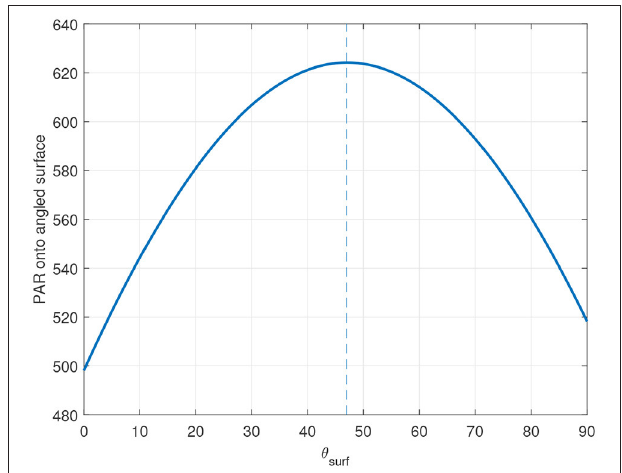
given sun height. Given the angle θ i , the script returned a direct and a diffuse PAR of λ dir = 540 µ mol m − 2 s − 1 and λ dif = 313 µ mol m − 2 s − 1 , respectively. PAR onto a plane normal to the direct irradiance is then λ ⊥ = λ dir + λ dif . By multiplying the direct PAR by the cosine of the sun angle and adding the diffuse PAR, we obtain the total PAR value for a horizontal surface as: λ k = cos (90 ◦ − φ i ) λ dir + λ dif . When reducing the λ ⊥ by the reflectivity factor we get the PAR = (1 − R )( λ dir + λ dif ). To get the PAR value after reflection, λ ′ ⊥ onto a surface below the surface angled by θ surf , we project the direct part by multiplying by the cosine of φ t − θ surf :